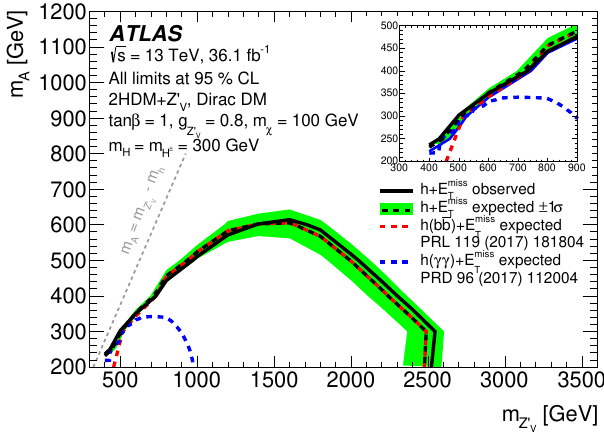
Figure 18. Exclusion contours for the 2HDM+ Z 0 scenario in the ( m ; m A ) plane for tan (cid:12) = 1, Z 0 V V = 0 : 8 and m (cid:31) = 100 GeV. The dashed lines indicate the expected exclusion contours from the g Z 0 V two separate channels and their statistical combination, while the black solid line shows the observed exclusion, presented only for the combined result. The band around the expected combined contour shows the e(cid:11)ect of a one-standard-deviation variation of the total systematic uncertainties. The sharp turn in the exclusion contour for m = 2 : 5 GeV is given by the opening A decay channels Z 0 V competing with the considered (cid:12)nal state for m A > 2 m t . For this reason the exclusion sensitivity does not depend on m A below threshold. The inset in the top-right side of the panel shows a zoomed-in version of the result for low m masses to highlight the complementarity between Z 0 V